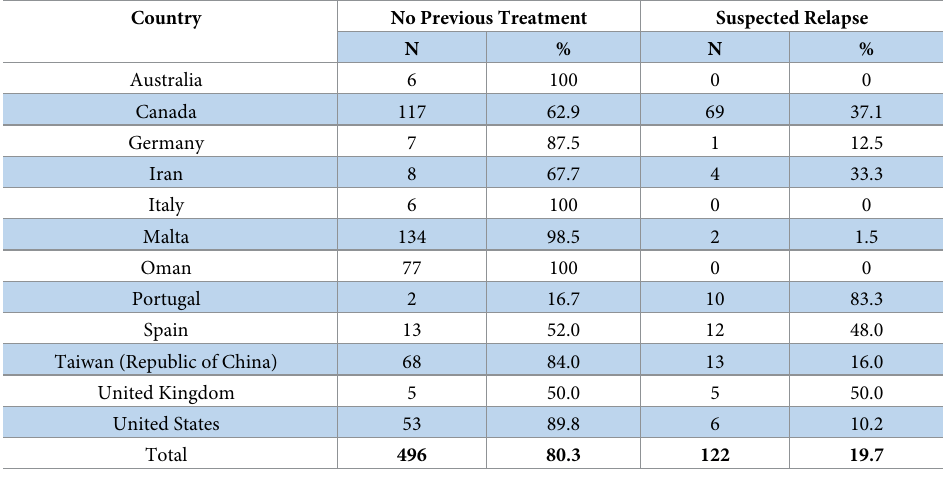
Table 6. Reported cases with no previous treatment for leprosy confirmed and those suspected to have relapsed. Country No Previous